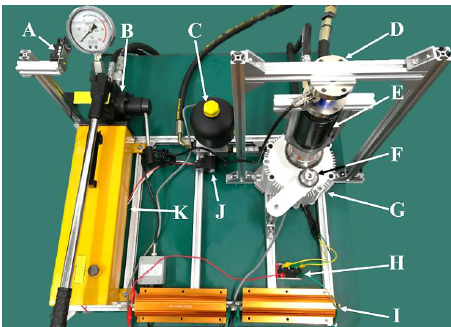
Figure 5. Circuit diagram of the experimental system. Note: T represents the torque transducer; G is the electric generator; E is the rotary encoder; and U, V, and W are the three winding coils of the generator.